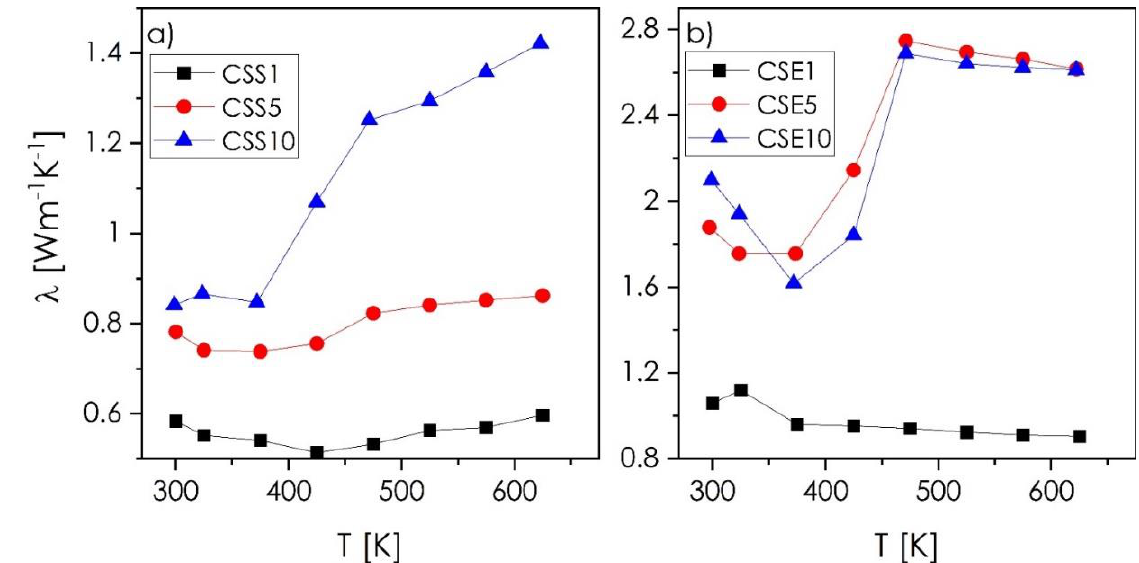
Figure 8. Thermal conductivity as a function of temperature recorded for sulfur-rich ( a ) and selenium-rich ( b ) composite ingots.